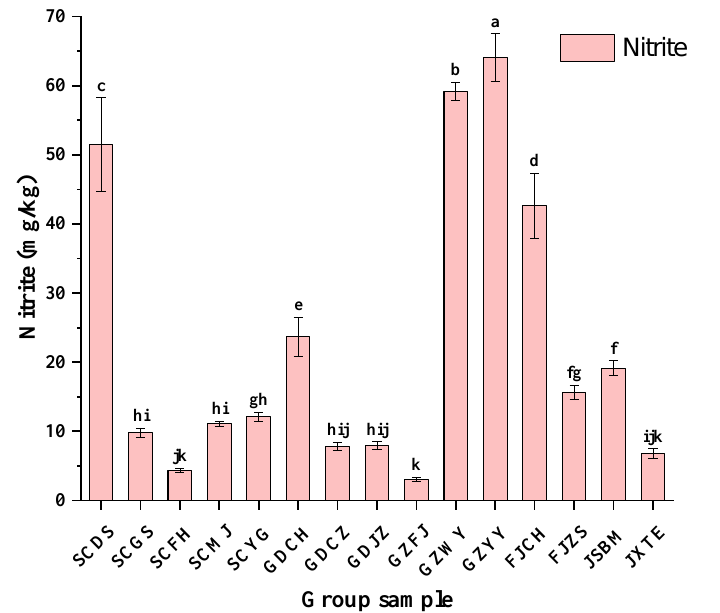
Figure 2. Contents of nitrite in FM samples. Different letters (a, b, c, etc.) indicate significantly different means at p < 0.05.